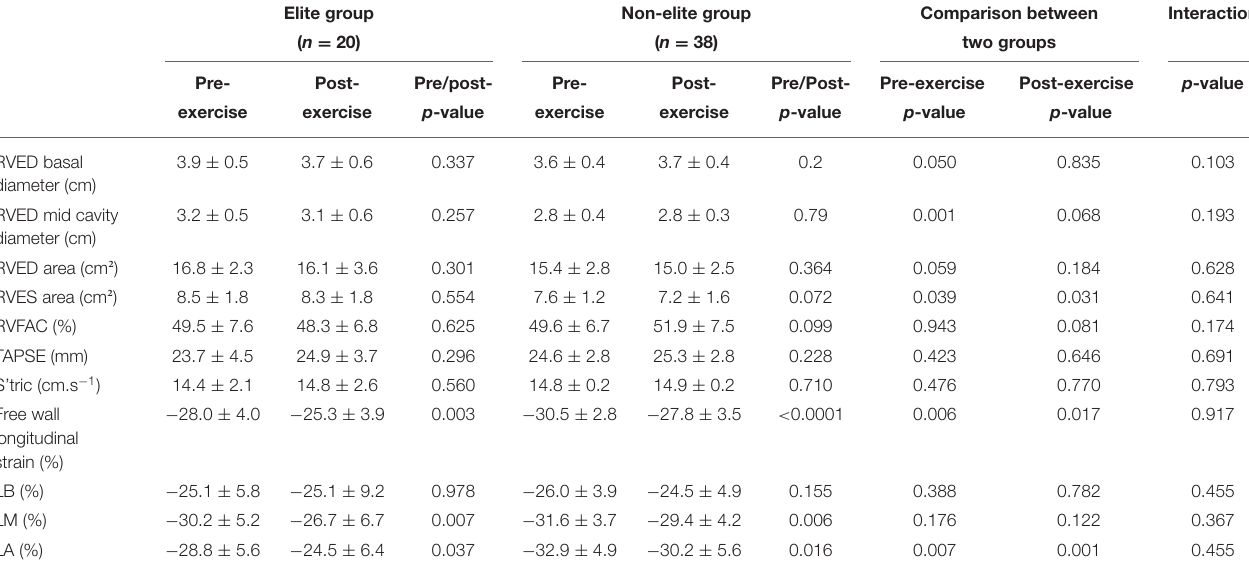
TABLE 3 | Right ventricular echocardiographic parameters. Elite group Non-elite group Comparison between Interaction